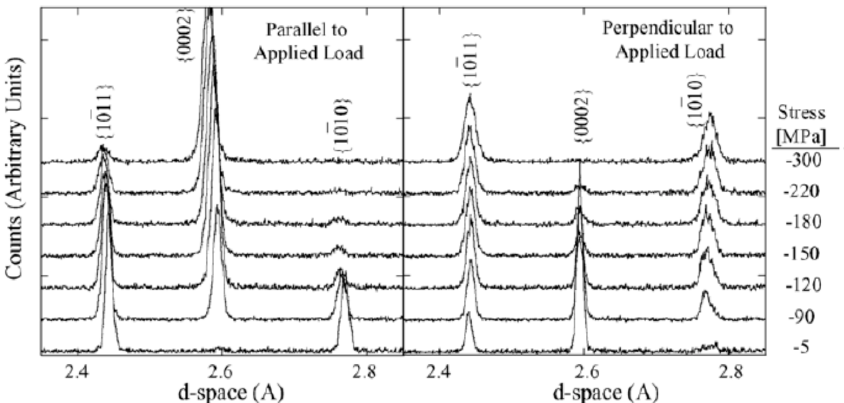
Figure 35. The diffraction pattern of the AZ31B Mg alloy subjected to in-plane compression loading in parallel and perpendicular detector banks at different stress values (After Brown et al. [34]).